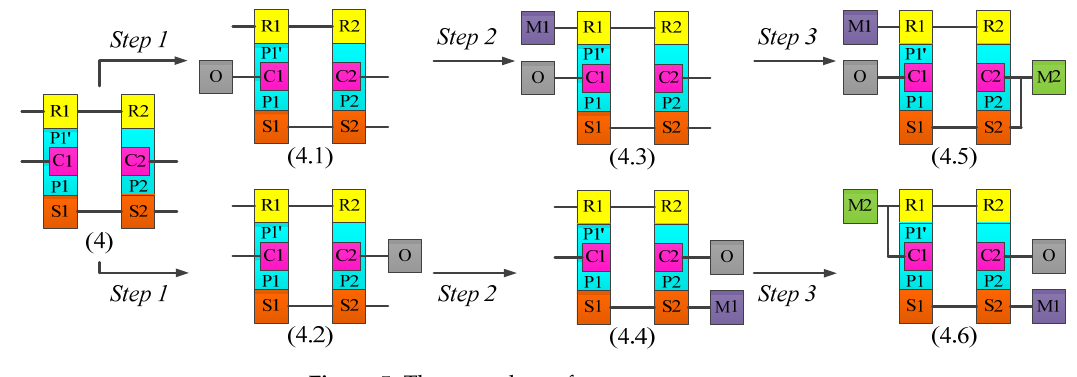
Figure 5. The procedure of power arrangement.